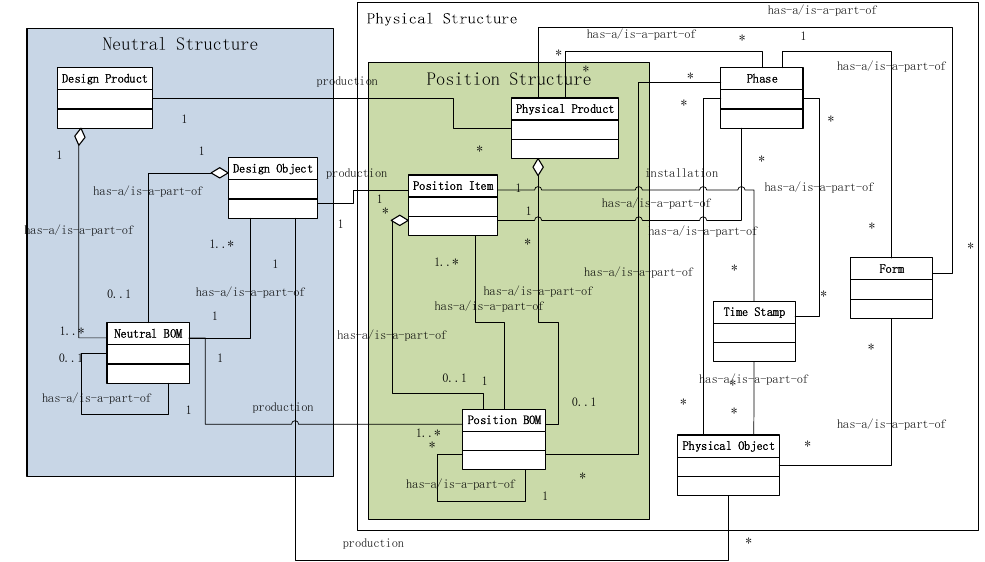
Figure 7. Physical Core Data Model (1, * represent the one and